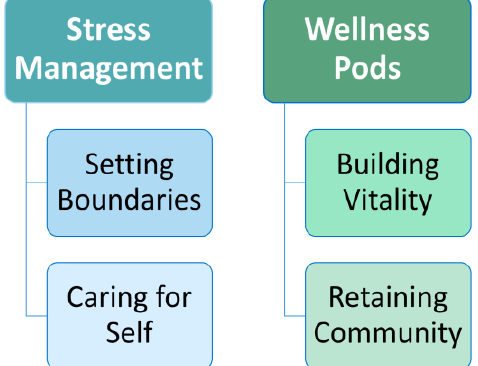
Figure 1. Qualitative Analysis: Categories and Subcategories .